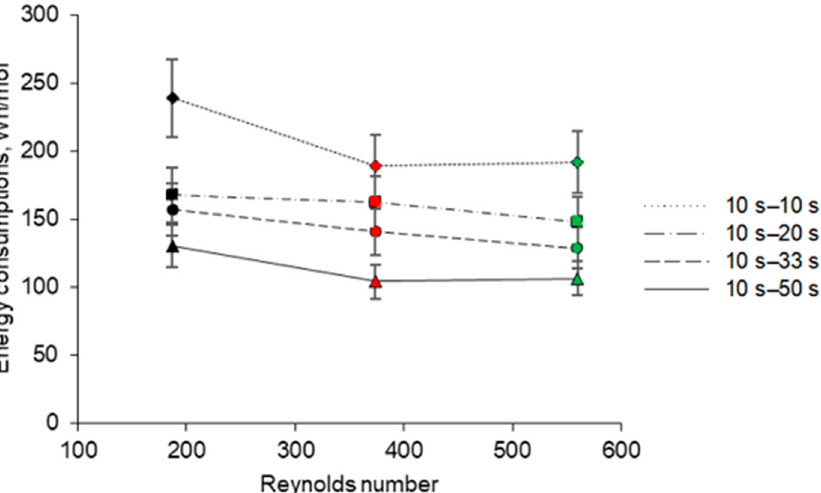
Figure 9. Energy consumptions normalized by the mole number of Na + ions transported through the CEM (in Wh/mol) during EDBM depending on the Reynolds numbers under different PEF current modes with pulse–pause durations of 10 s–10 s, 10 s–20 s, 10 s–33 s and 10 s–50 s. Reynolds numbers of 187, 374 and 560 correspond to linear velocities of 7.8, 15.6 and 23.4 cm/s, respectively.